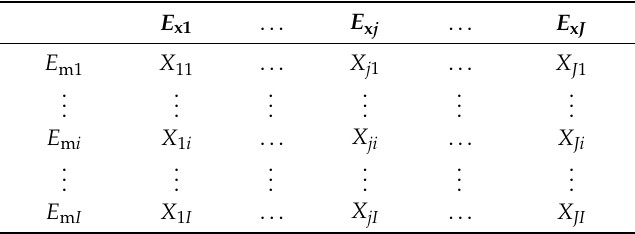
Table 1. The excitation-emission matrix